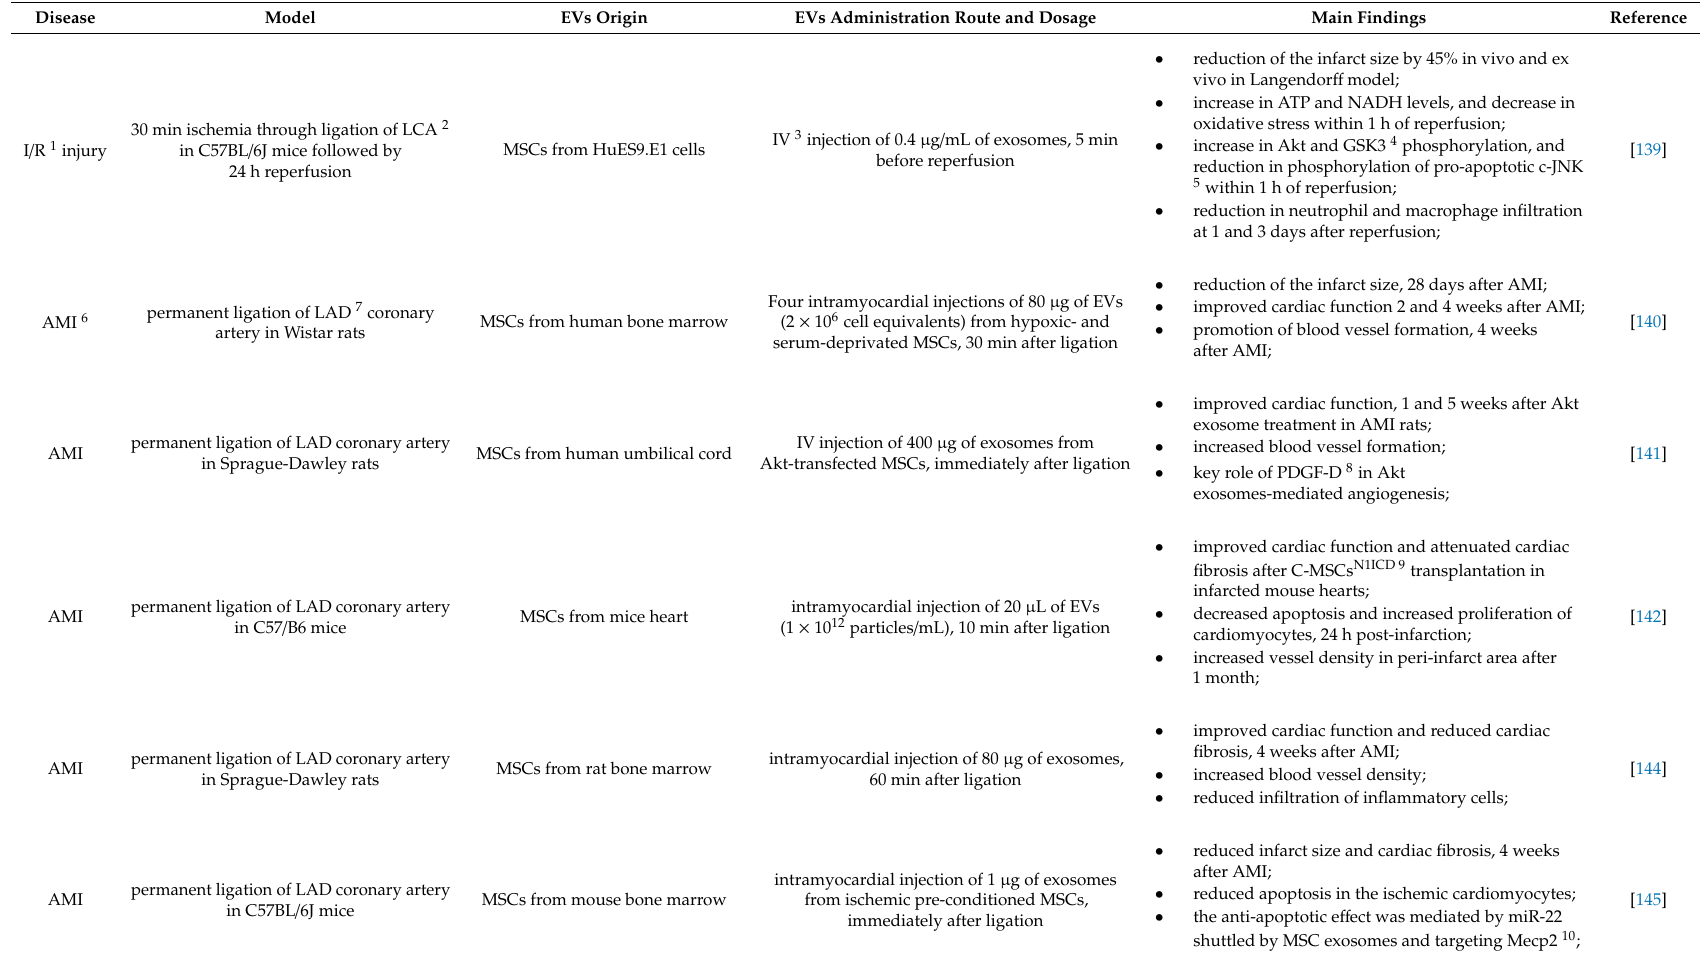
Table 2. Successful use of MSC-derived EVs (MVs or exosomes) in heart